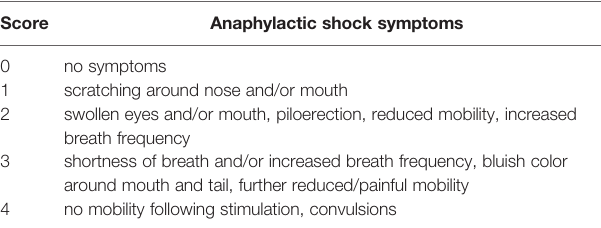
TABLE 1 | The list of anaphylactic symptoms used as the scoring criteria in food allergy